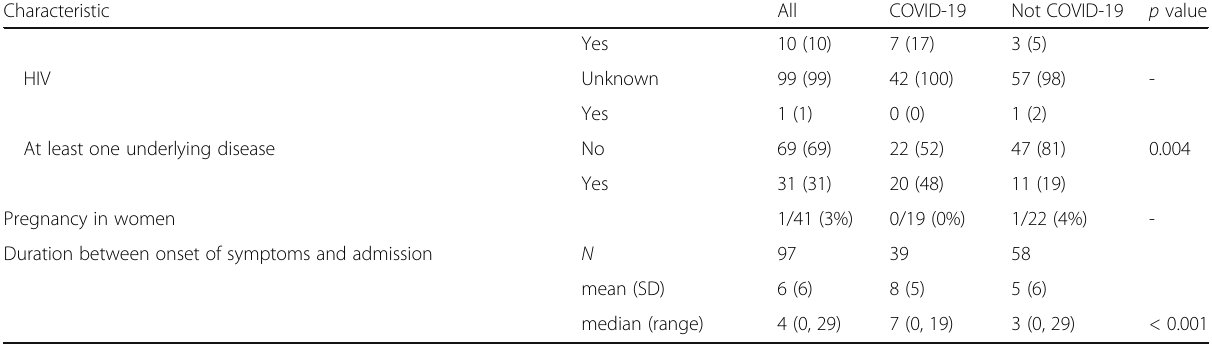
Table 1 Demographic and baseline characteristics of suspected COVID-19 patients (Continued)